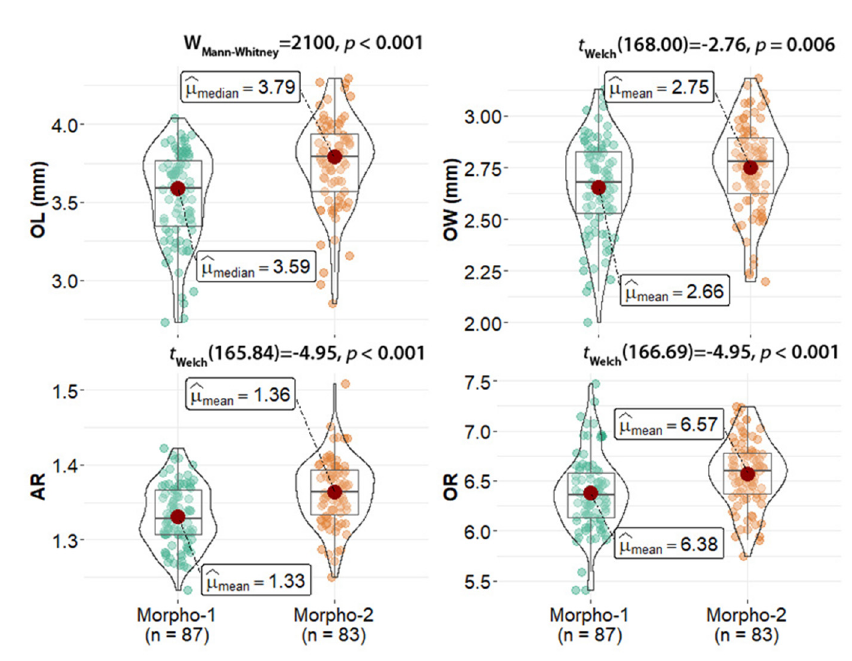
Figure 4. Otolith length (OL), width (OW), aspect ratio (AR), and otolith relative length (OR) for each specimen analyzed.